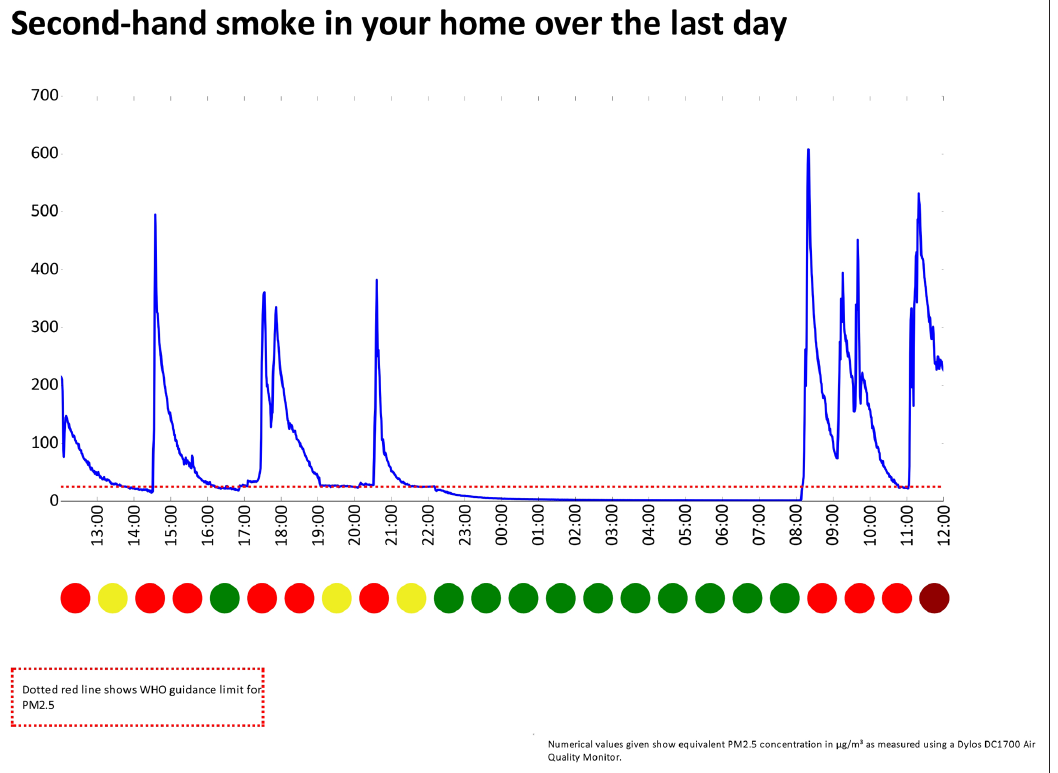
Figure 7: Examples of revised personalised feedback from a home where smoking takes place. Dotted red line shows WHO guidance limit for PM . Numerical values given show equivalent PM 2.5 using a Dylos DC1700 Air Quality